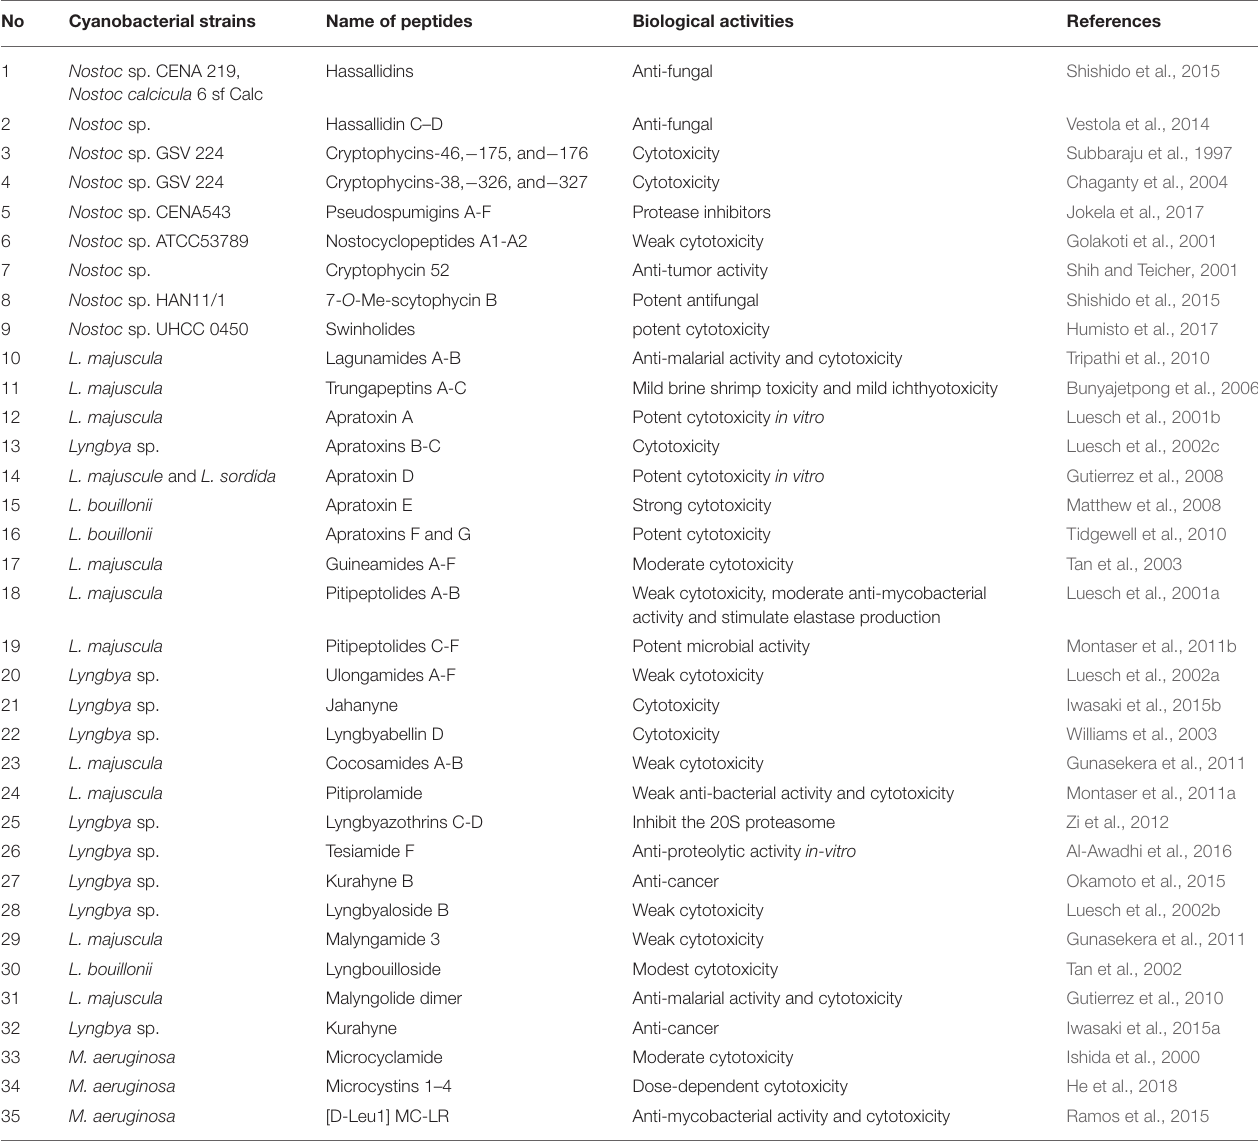
TABLE 4 | Lists of polyketides and peptide class